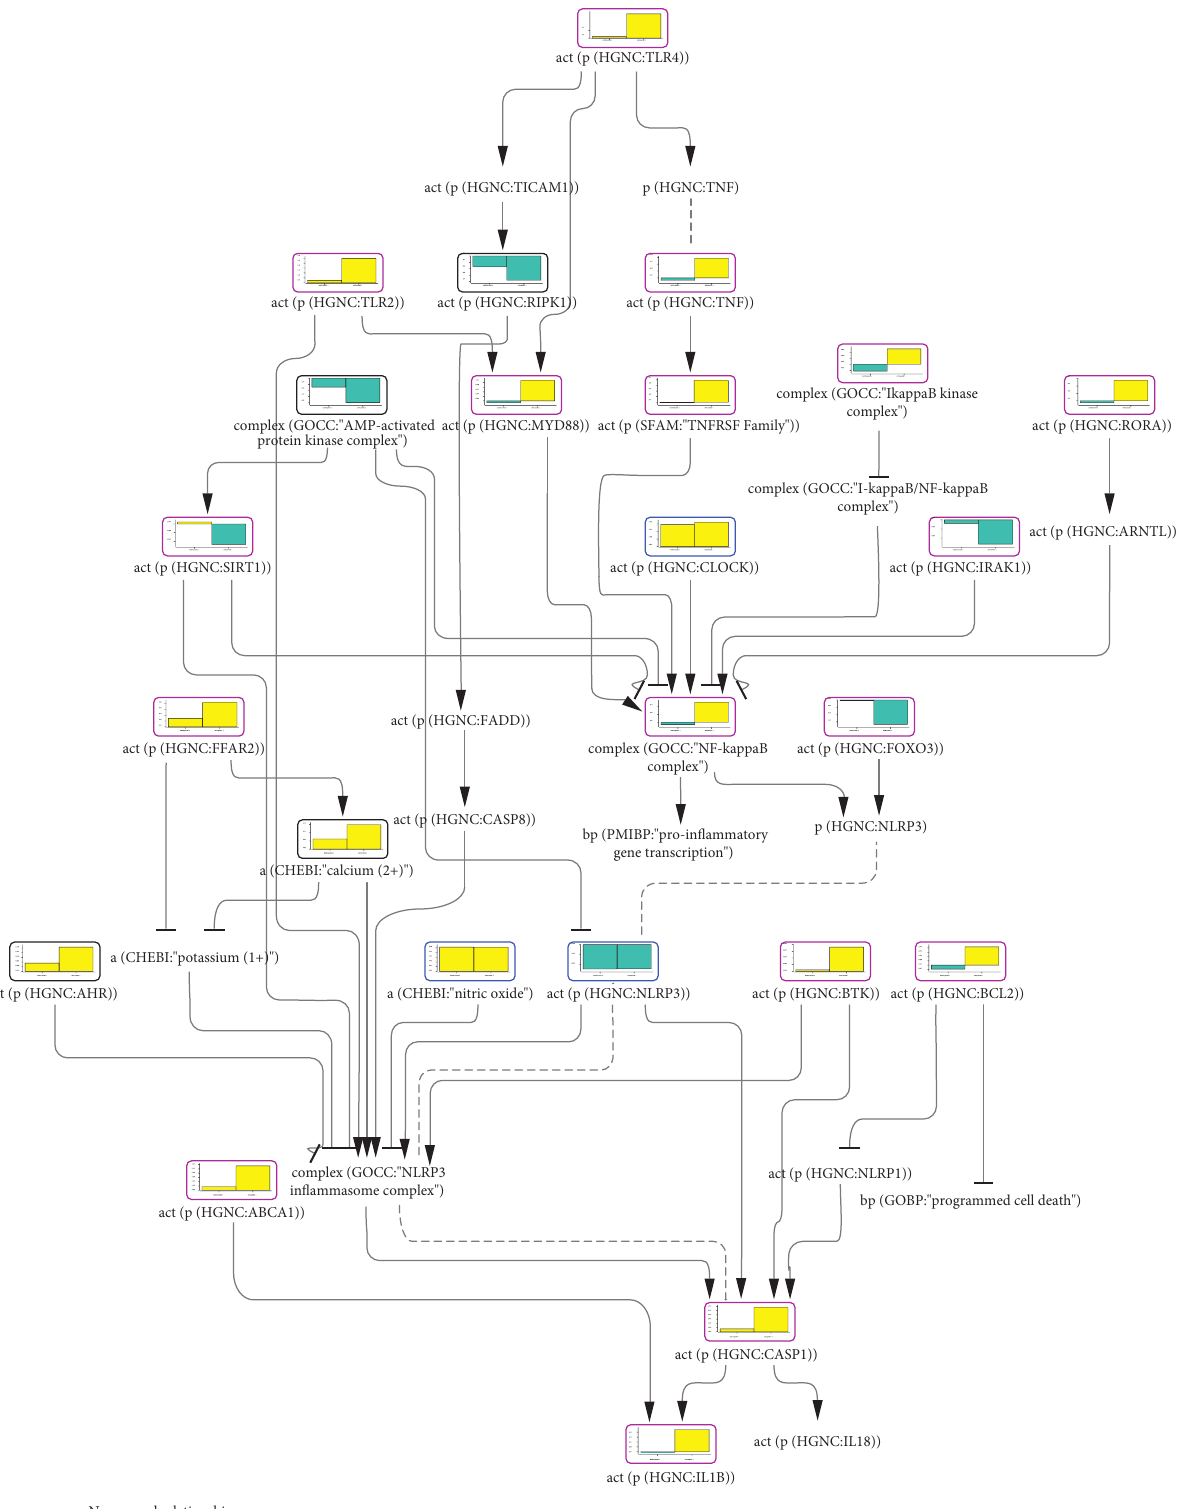
Figure 3: Part of the inflammasome network model scored with transcriptomic data from GSE2737. The bar graph above each node, which was scored, shows the inferred fold change in the (1) unaffected and (2) affected skin areas of psoriatic patients relative to the skin of healthy controls. The directionalities are shown as yellow or blue bars for inferred upregulation or downregulation, respectively. The black outline refers to nodes that were significantly impacted in both samples, the blue outline refers to nodes that were significantly impacted only in unaffected skin samples, and the purple outline refers to nodes that were significantly impacted only in affected skin